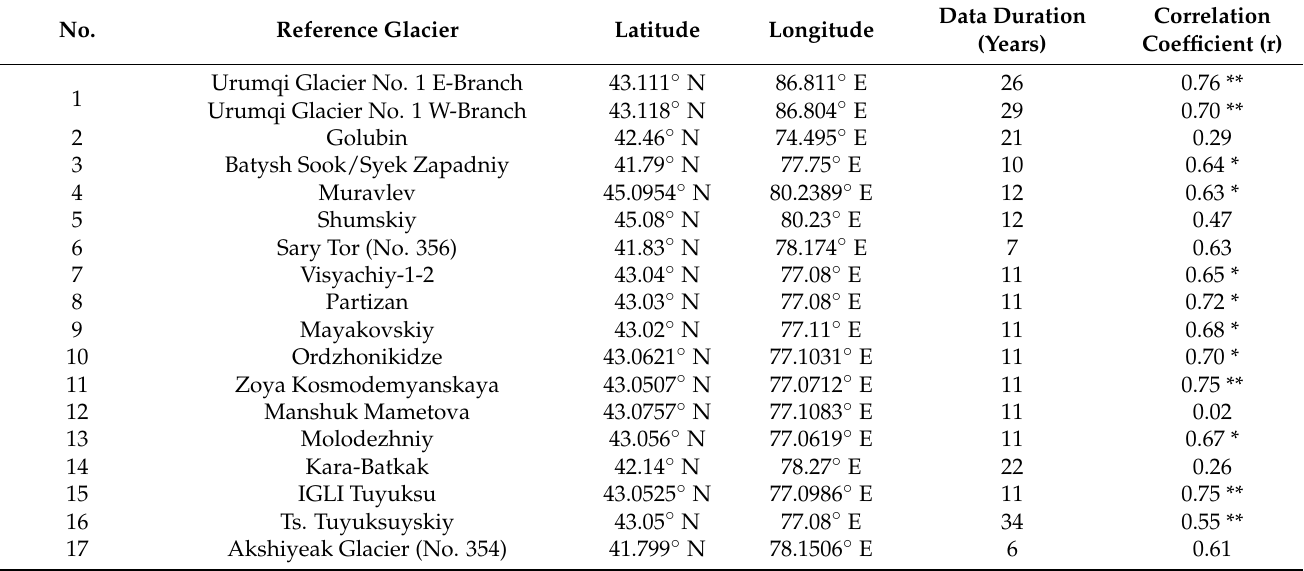
Table 1. Details of the 17 reference glaciers and the correlation coefficients between the PyGEM- Interim glacier mass balance simulated data and the WGMS measured data in the Tien Shan Moun- tains of Central